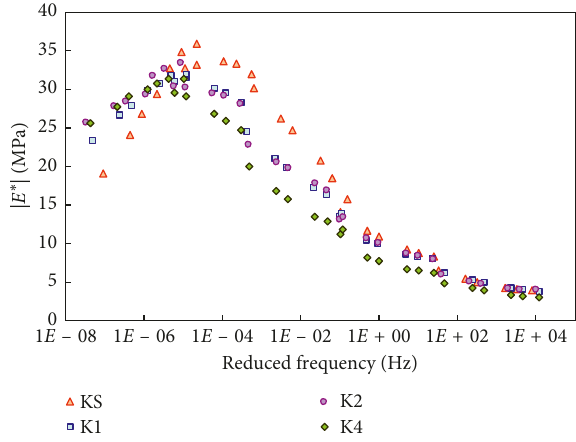
Figure 5: Phase angle master curves for all four mixtures. Figure 6: Log shift factor function for all four mixtures. Table 3: Linear viscoelastic quantities for all four mixtures.